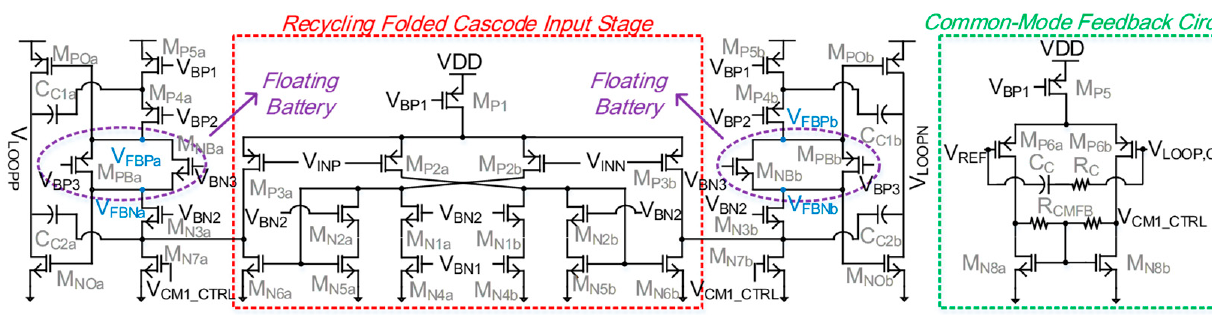
Figure 3. Block diagram of the proposed current-mode line driver with an adaptive amplitude tuning.